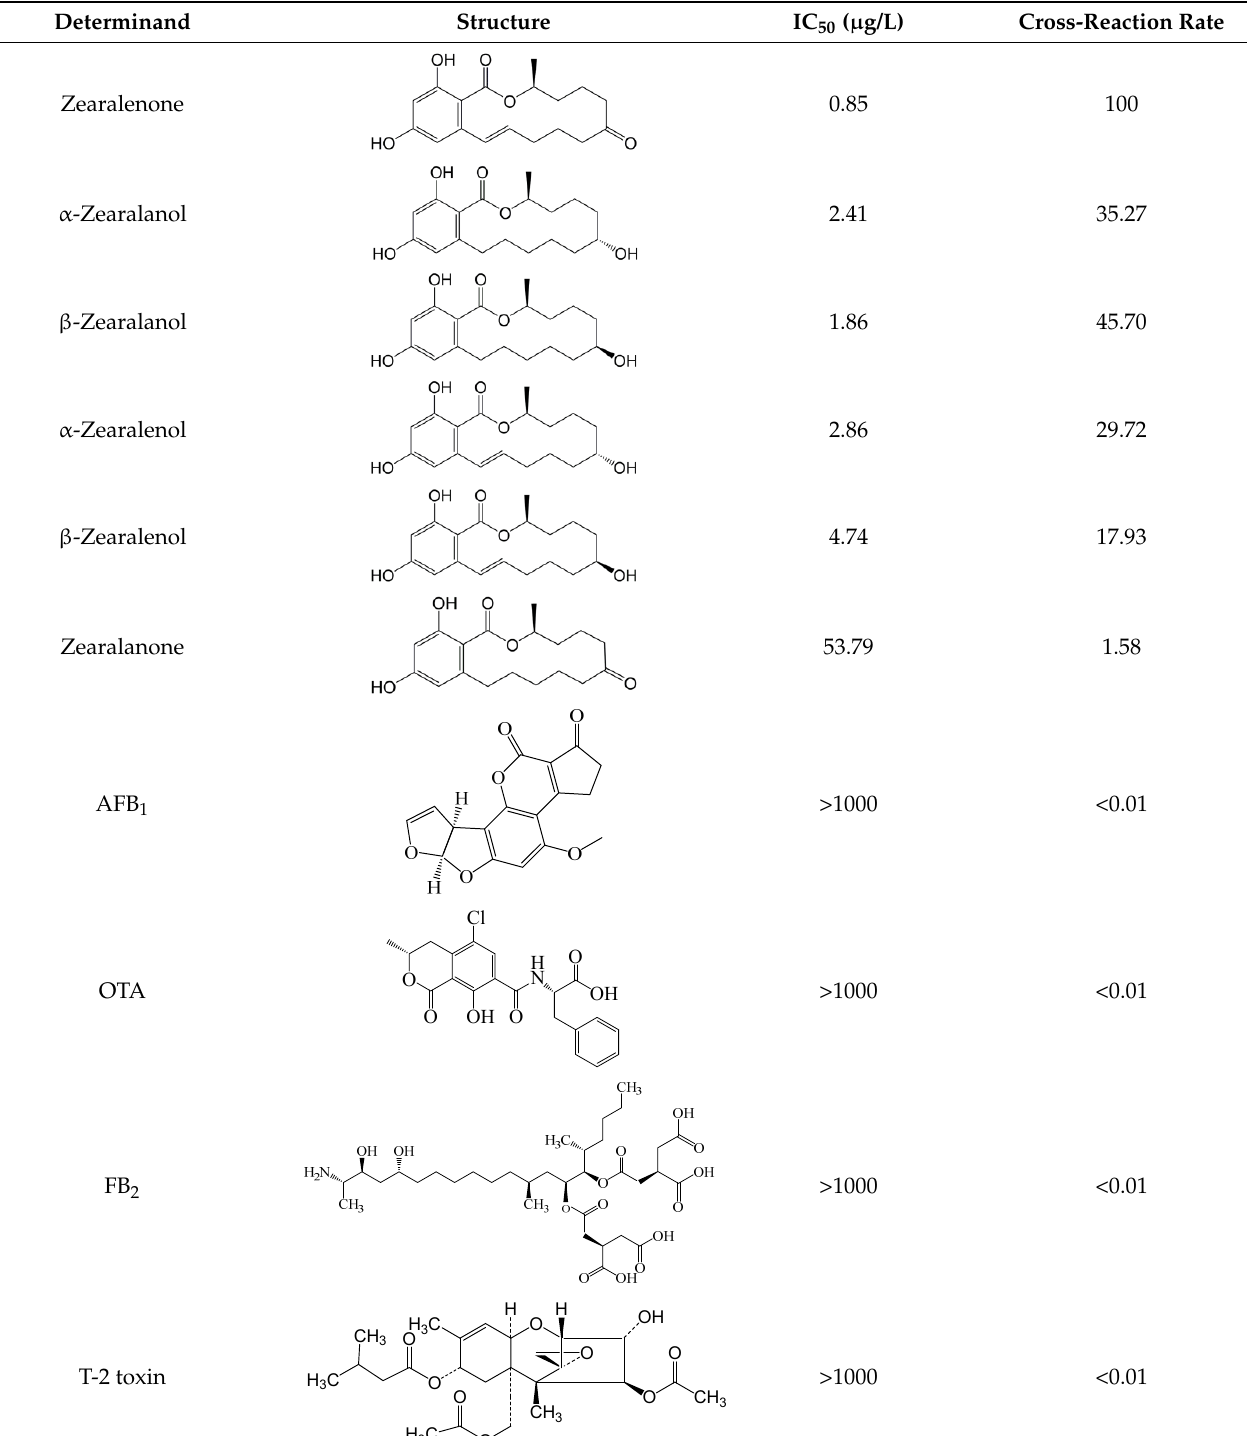
Figure 1. Standard curve of ZEN by ic-ELISA.